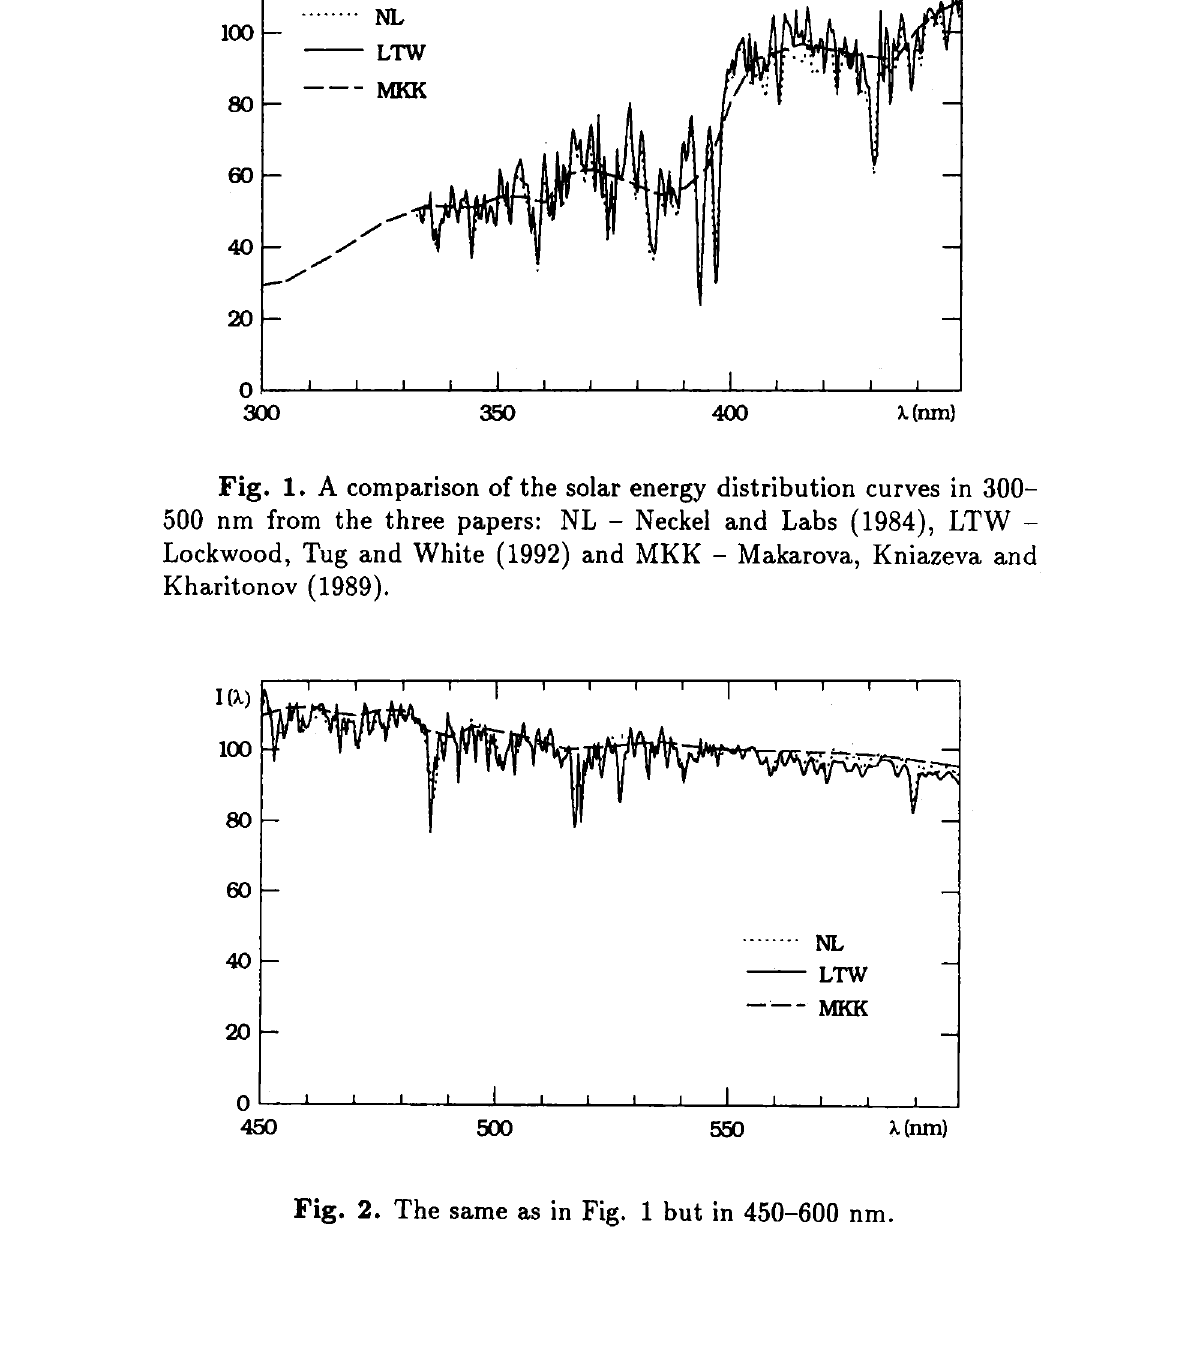
Fig. 2. The same as in Fig. 1 but in 450-600